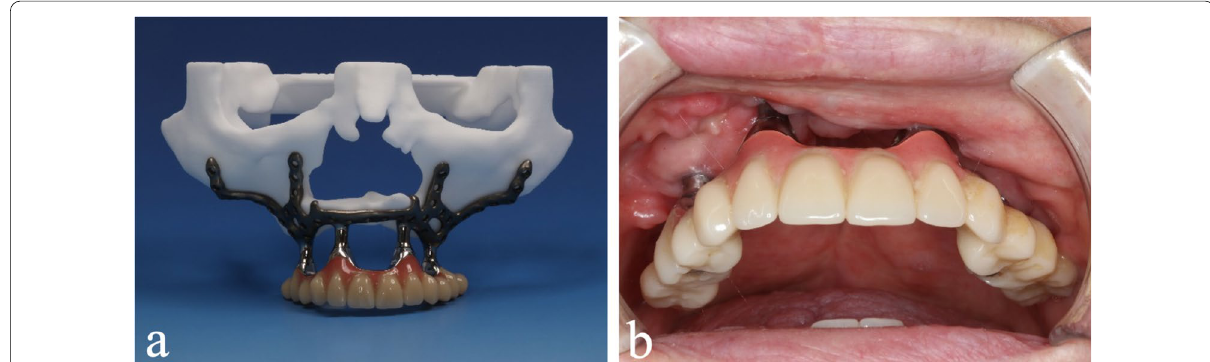
Fig. 7 Temporary superstructure. The screw‑retained temporary superstructure on the IPS‑preprosthetic ® mounted on a stereolithography model ( a ) and a clinical example ( b